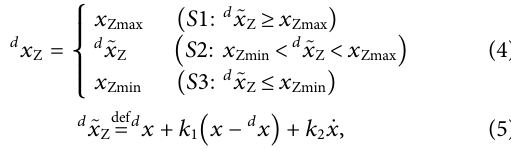
(cid:1)(cid:1)(cid:1)(cid:1)(cid:1)(cid:1)(cid:1)(cid:1) √ 9 . 8/0 . 27